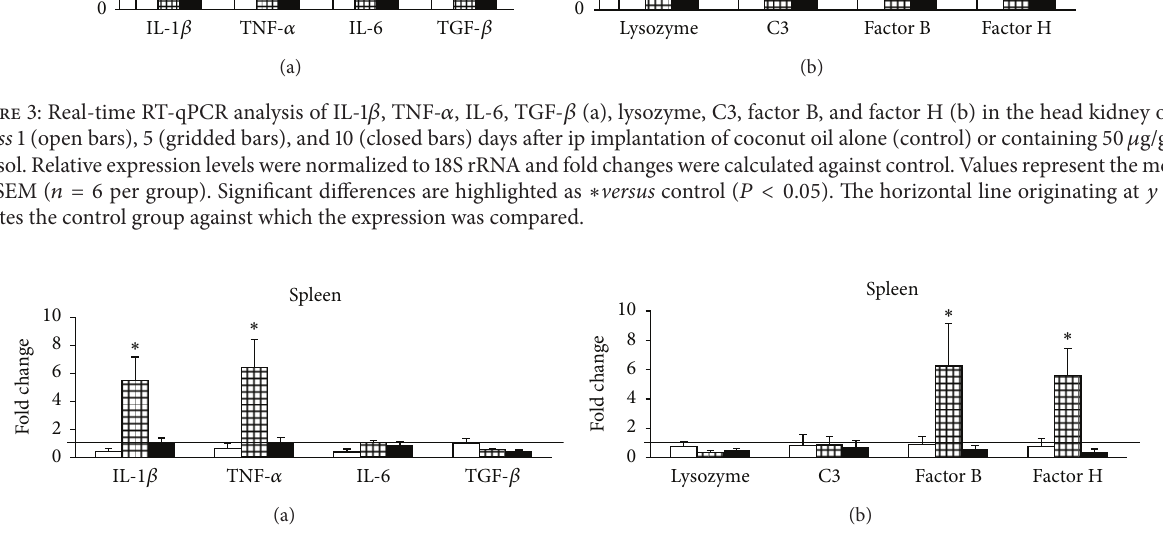
Figure 4: Real-time RT-qPCR analysis of IL-1 𝛽 , TNF- 𝛼 , IL-6, TGF- 𝛽 (a), lysozyme, C3, factor B, and factor H (b) in the spleen of O. mykiss 1 (open bars), 5 (gridded bars), and 10 (closed bars) days after ip implantation of coconut oil alone (control) or containing 50 𝜇 g/g bw cortisol. Relative expression levels were normalized to 18S rRNA and fold changes were calculated against control. Values represent the means and SEM ( 𝑛 = 6 per group). Significant differences are highlighted as ∗ versus control ( 𝑃 < 0.05 ). The horizontal line originating at 𝑦 = 1 denotes the control group against which the expression was